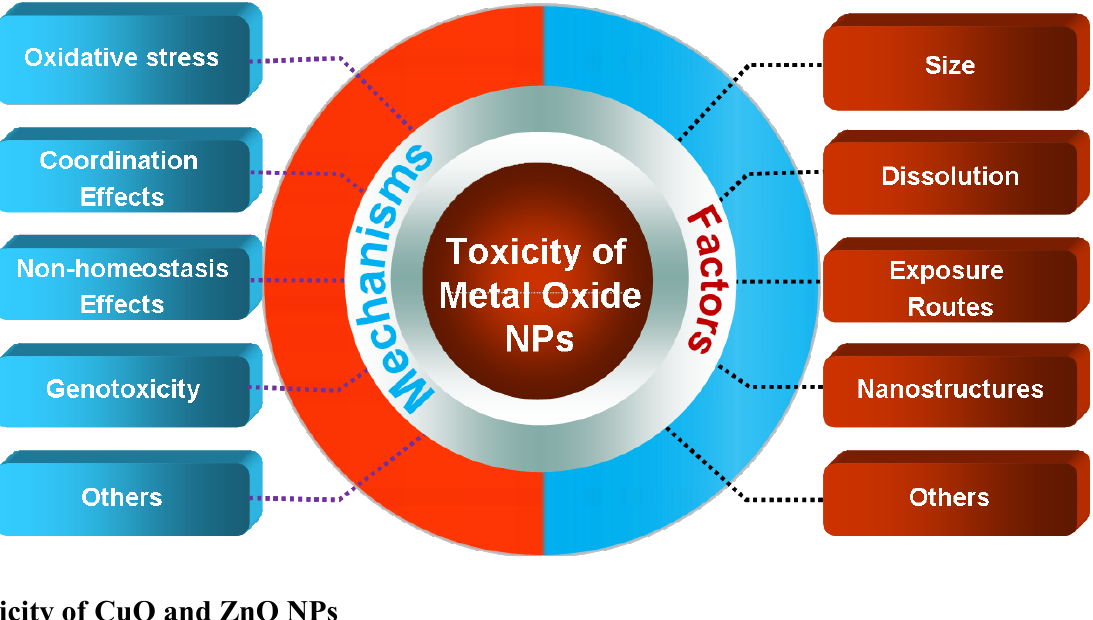
Figure 1. Schematic overview summarizing the toxic effect of CuO and ZnO NPs. The key factors that result in toxicity include particle size, dissolution, exposure routes, and structures, etc . The damaging mechanisms include oxidative stress, coordination effects, non-homeostasis, and genotoxicity, etc